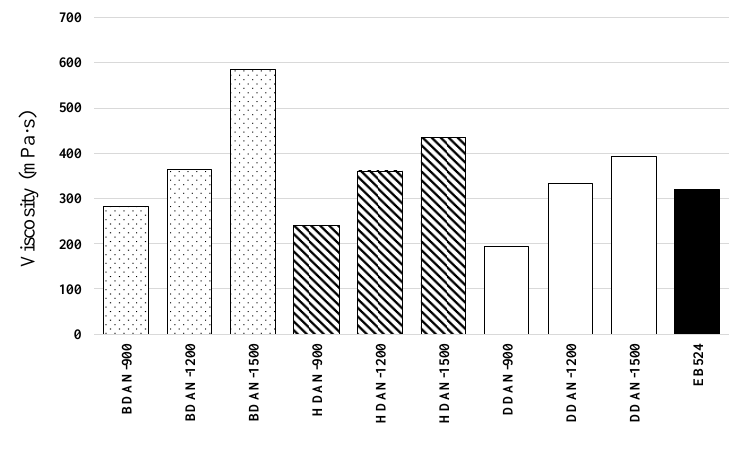
Figure 10. Viscosity values of wet inks.